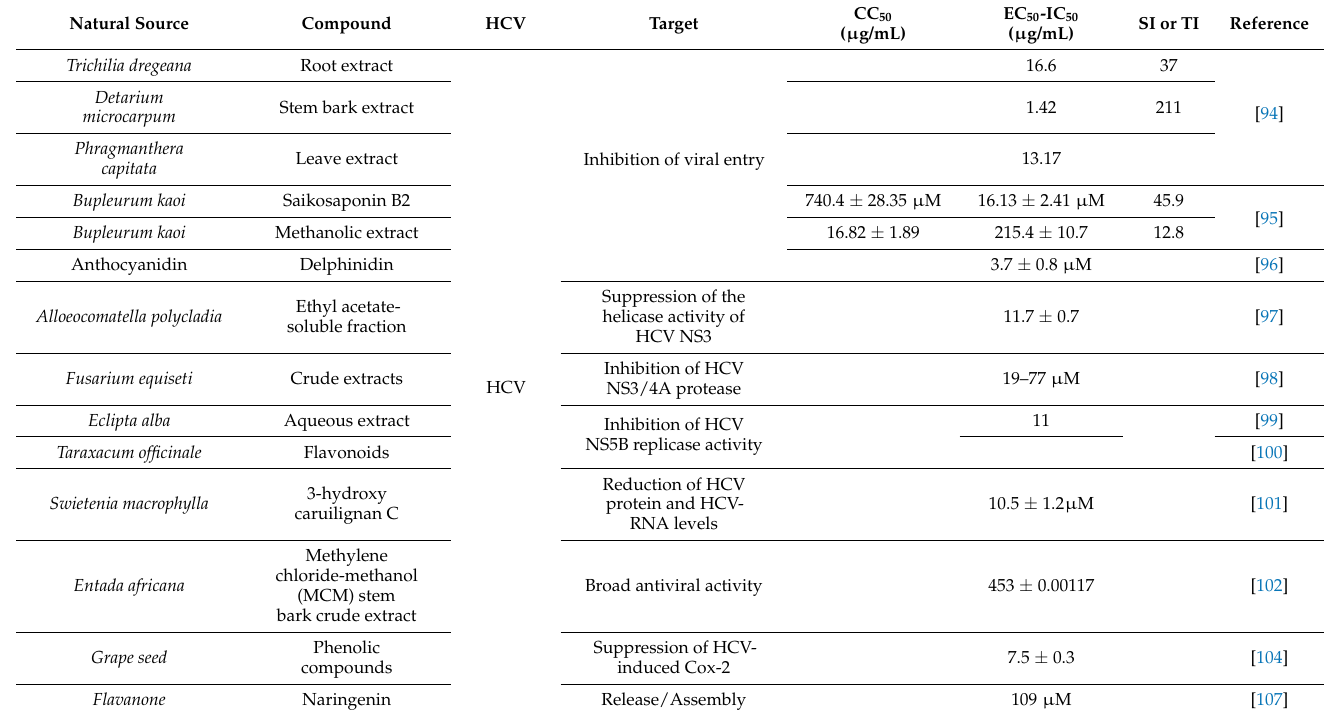
Table 7. Natural products against Hepatitis C